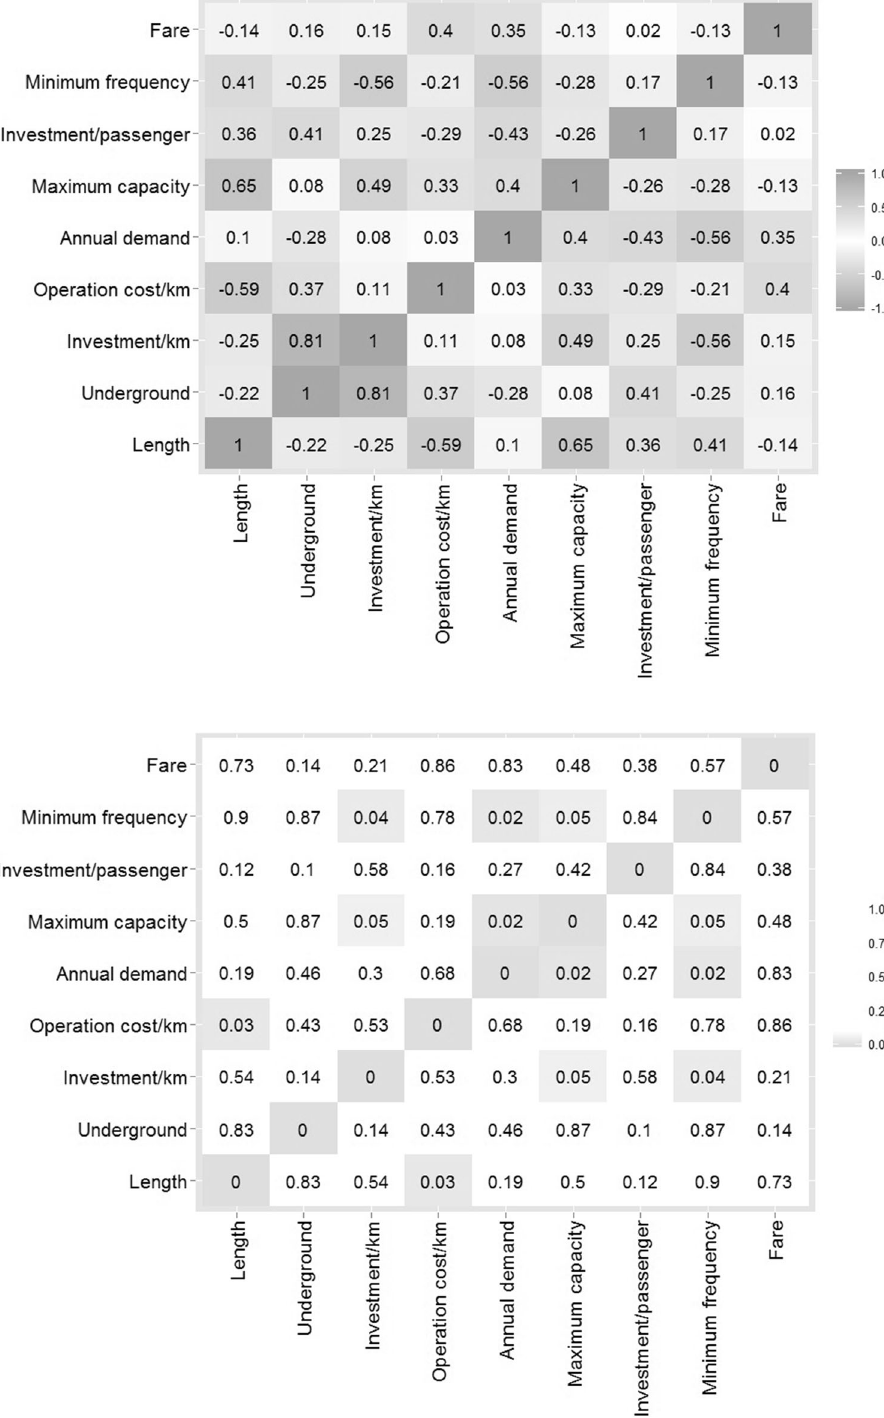
Fig. 3 Kendall’s Tau test p values for each pair of